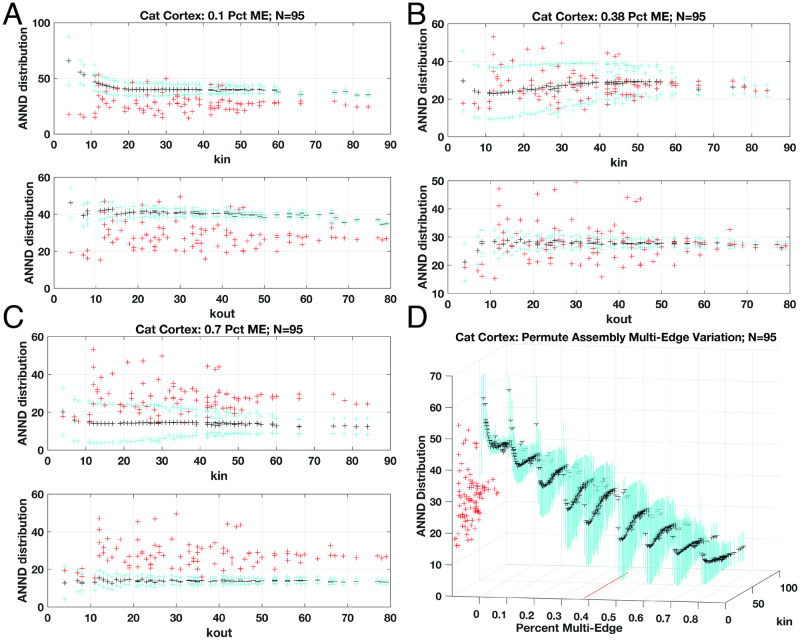
Weighted directional network generations for the cat cortical and thalamus neuronal system with N = 95 nodes.Scatter plots show the mean (black), one standard deviation (cyan lines) and original data (red) for ANND computed per in- and out- degrees. Three levels of prescribed multi-edge proportions for null model suites presented for 10%, 38% (as found in raw data), and 70% in Panels A, B and C, respectively. Distributions for kin ANND values shown over range from no multi-edges (simple network) to 80% in Panel D, with real-network ANND values shown along leftmost plane for comparison. Actual proportion of 38% indicated with red trace at z = 0 for comparison. Note significant reduction in ANND values as multi-edge densities increase with asymptotic approach to minimal means, yet standard deviations increase substantially as proportions pass through real-network proportion (cyan vertical traces), then diminish. Note, vertical axis truncates plot for visibility at ANND value of 70 whereas maximal deviations reach up to approximately 100.